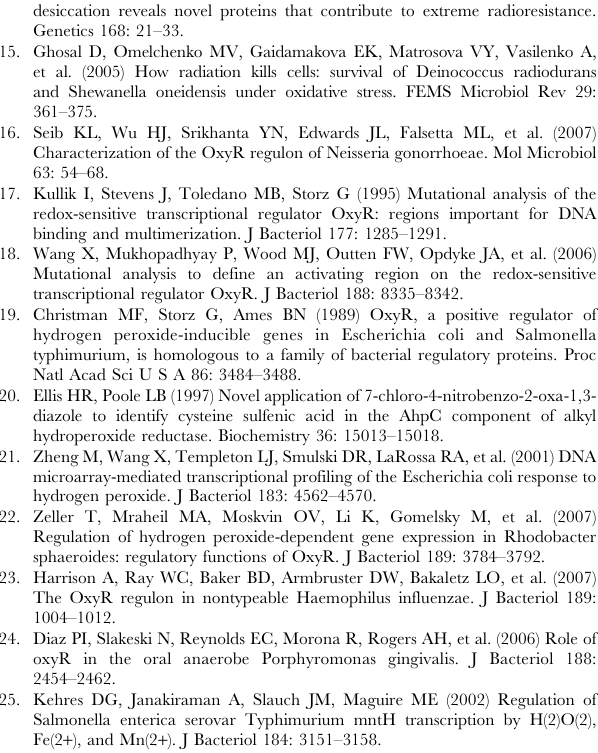
Figure S1 H2O2 disk assay. Photos showing the zones of inhibition by H2O2 in E. coli K-12 (wild type) (A), GS09 (oxyR::kan mutant) (B), and E. coli K-12 strain GS09 comple- mented with the droxyR gene (C). (D) Histogram showing the results of H2O2 disk assay in E. coli. In the assay, E. coli cells were grown in Luria-Bertani (LB) broth at 37 u C with overnight shaking. 200 m l of the overnight cultures were added to LB top agar and spread onto LB agar. Then, 10 m l of 3% H2O2 was pipetted onto 3MM Whatman paper disks (0.7-cm diameter), and these disks were placed on top of the agar and incubated at 37 u C overnight. The zone of inhibition, in mm, was taken as a measure of H2O2 sensitivity. The zone of inhibition was measured in three dimensions, and the mean values and standard deviations were calculated. Figure S2 Disruption of D. radiodurans droxyR gene. Verifica- tion of droxyR gene disruption by PCR analysis. Purified PCR fragments were amplified from the genomic DNA of strain R1 and MOxyR using primers (OxyR1 and OxyR5) that flank the coding sequences for droxyR. The PCR products of R1 revealed a band of , 2550 bp length (band 1), whereas those of MOxyR resulted in a , 3500 bp fragment (band 2). Bands 3 and 4 denote PCR